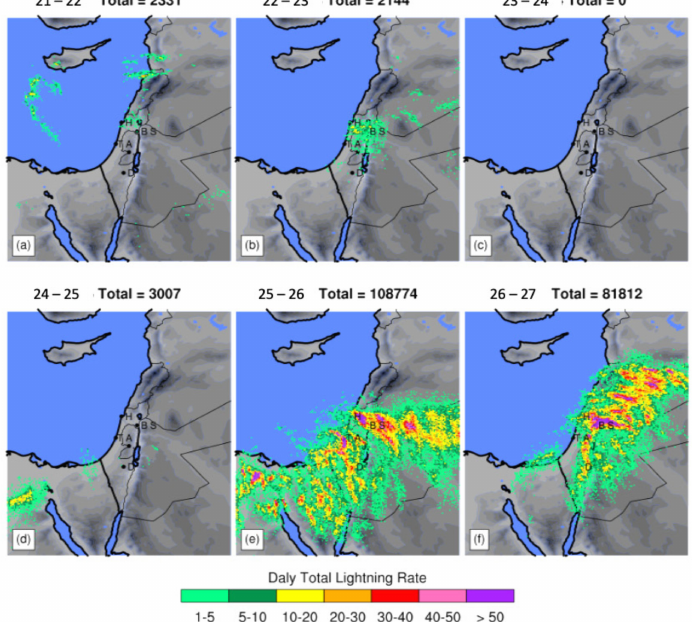
Figure 4. Daily observed total lightning for the 24 h time periods shown (e.g., ( a ) 21–22: 0000 UTC 21 April until ( e ) 0000 UTC 22 April 2018). The total number of recorded events within are also shown. The letter or letter combinations refer to the location of cities references within the text. T A refer to the city of Tel Aviv, B S to Bet She’an, H to Haifa, J to Jerusalem, and D to Dimona. Dimona is about 25 km to the Northwest of the Tzafit river basin where the students died in a